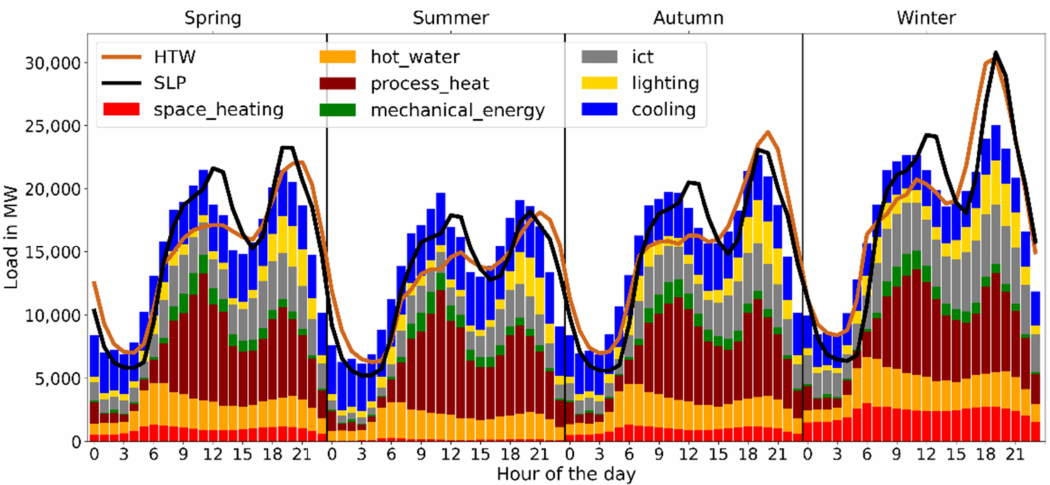
Figure 5. Seasonally average load curve of this work compared to German standard load profile (SLP) and HTW. Each season consists of three months starting with spring in March. Values are grouped by the hour of the